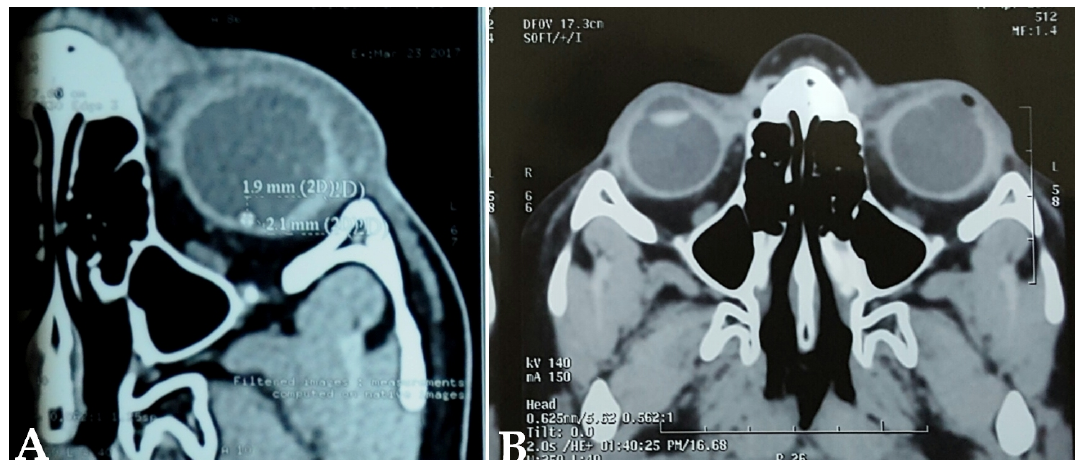
Figure 3: A: CT scan image after the initial surgery showing a round, 1.9 mm x 2.1 mm sized radio dense (400 Hounsfield Units) lesion close to the retina in the left globe. B: CT scan following aspiration of the PFCL bubble showing the absence of any radio dense